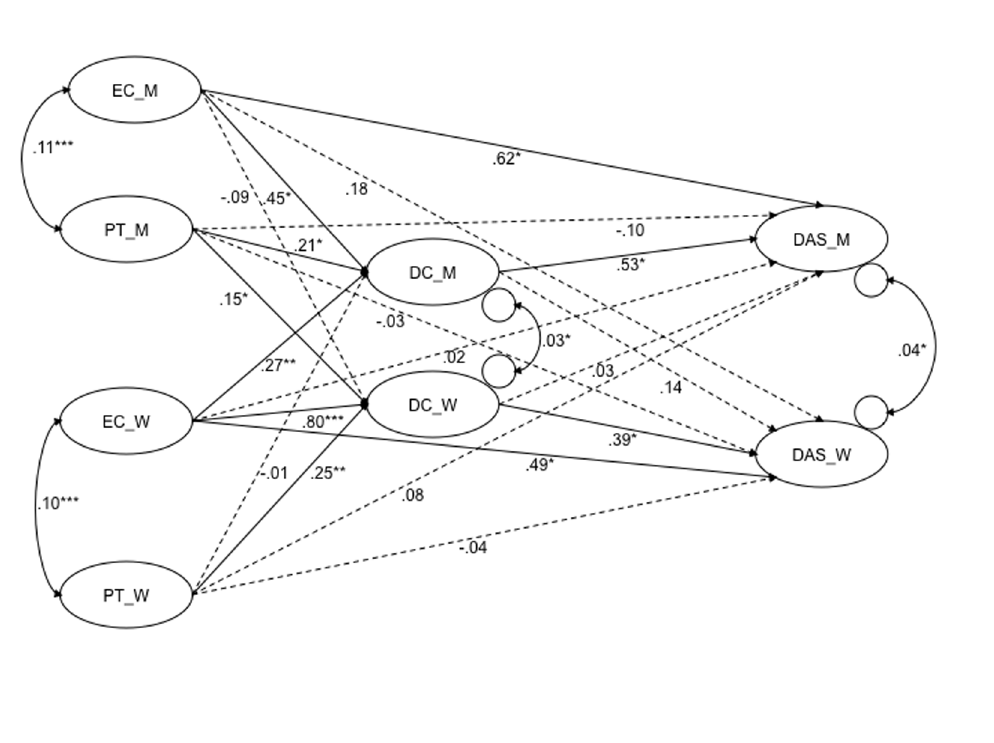
Figure 1. Unstandardized Coefficients for the Structural Equation Model showing the mediating role of dyadic coping in the Associations between dyadic empathy and relationship satisfaction for both partners. Note. EC = Dyadic Empathic Concern; PT = Dyadic Perspective-Taking; DAS = Relationship Satisfaction; DC = Dyadic Coping; M = Men; W =